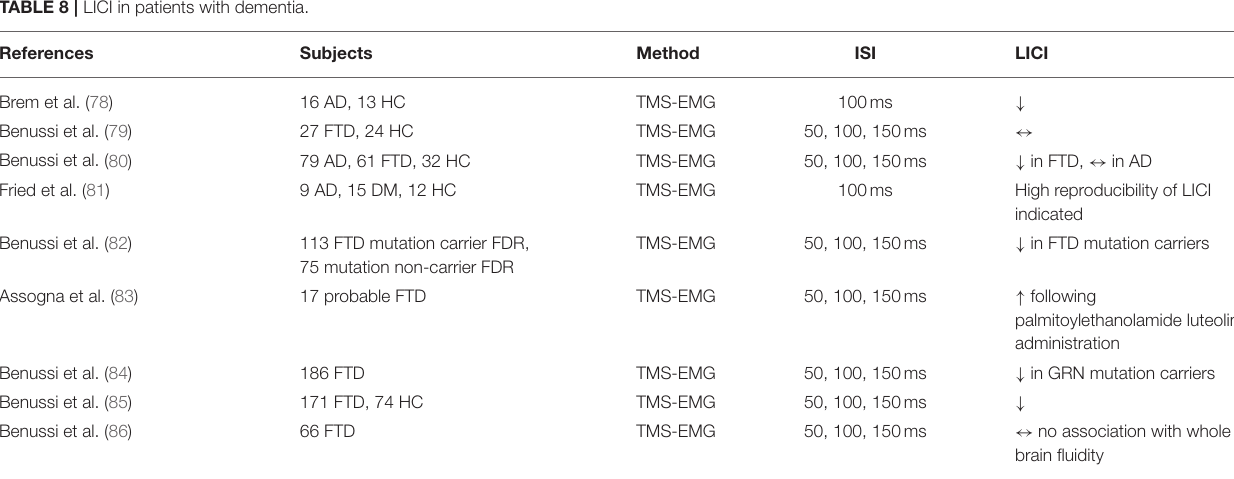
TABLE 8 | LICI in patients with